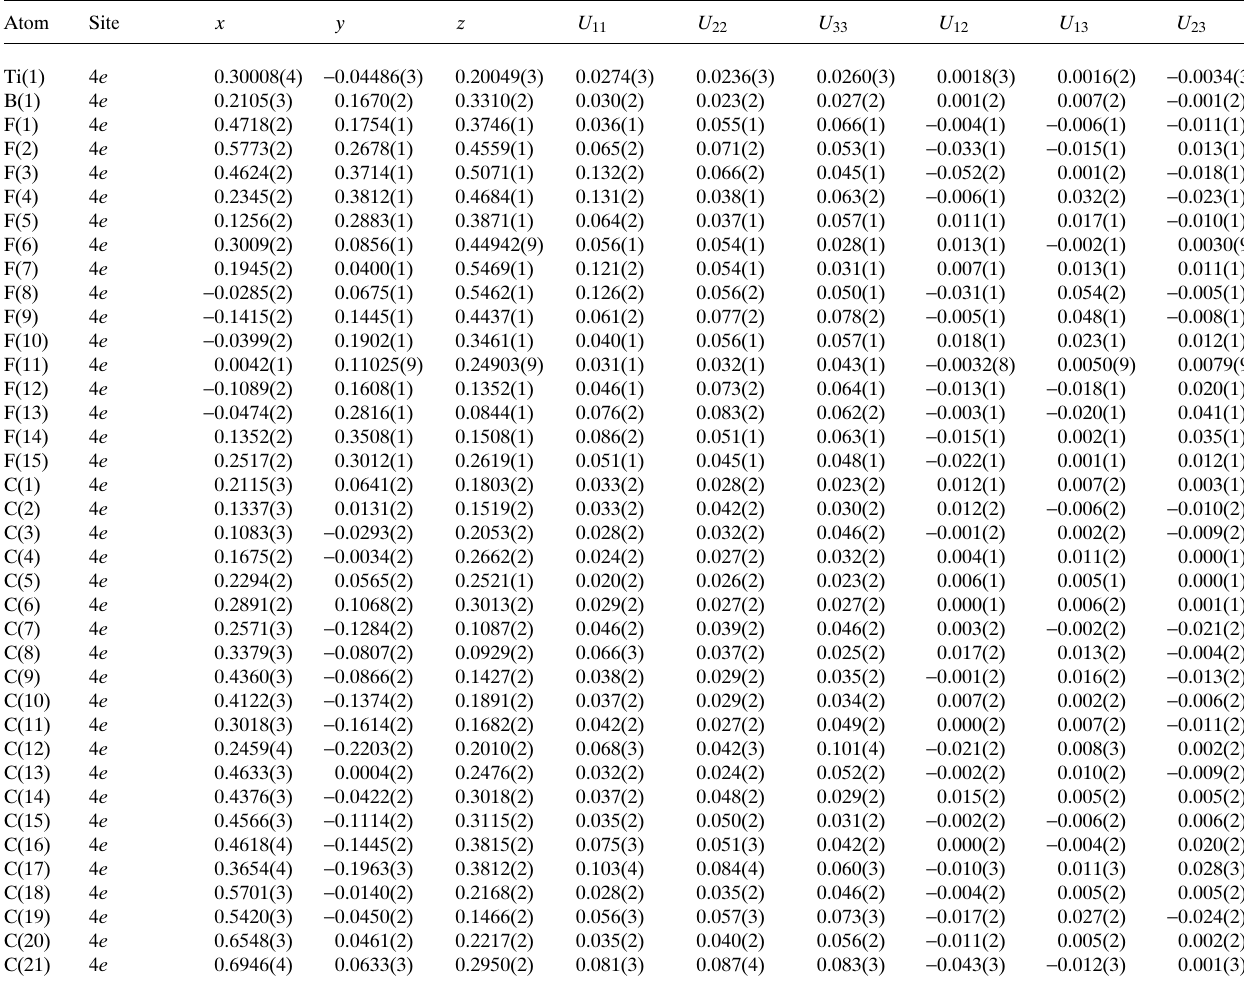
Table 3. Atomic coordinates and displacement parameters (in Å 2 ) .